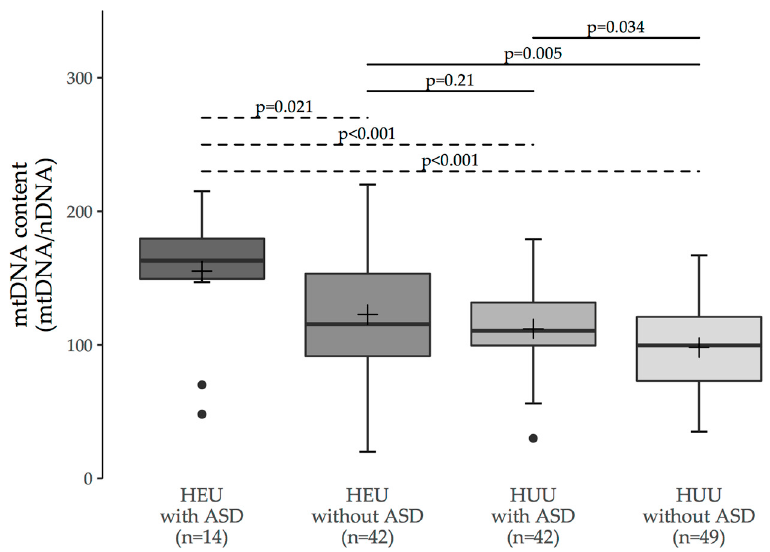
Figure 2. Between-group comparisons of blood mtDNA content in HIV-exposed uninfected (HEU) and HIV-unexposed uninfected (HUU) children with and without ASD. p -Values are reported for Student’s t -test (solid lines) or Mann-Whitney U-test (dashed lines).